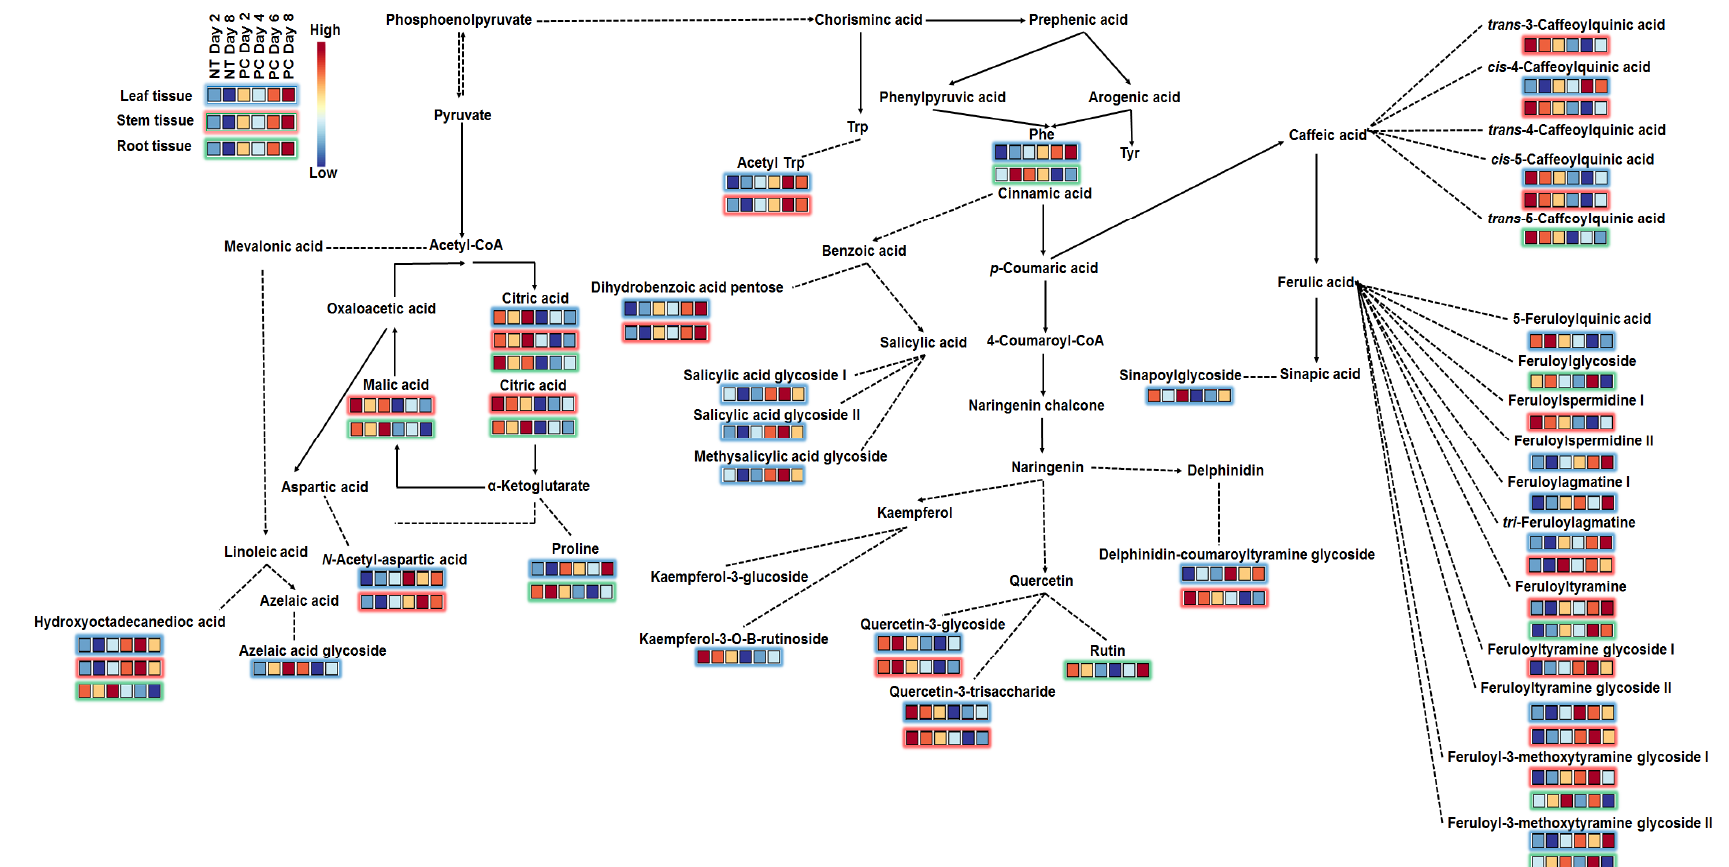
Figure 6. Metabolic changes in Phytophthora capsici -infected plant tissues (roots, stems, and leaves) over the time period of 2–8 d.p.i. Selected metabolites (VIP score ≥ 0.5) in infected plants were compared to those in control plants at the given time point. Blue boxes indicate down regulated metabolites/associated with the control, while red boxes indicate up regulated metabolites/associated with the treatment. Solid lines with an arrow indicate a single reaction, dotted lines with an arrow indicate multiple reactions, and dotted lines with no arrows indicated conjugation. NT = non-treated and PC = P. capsici, (stem - inoculated).